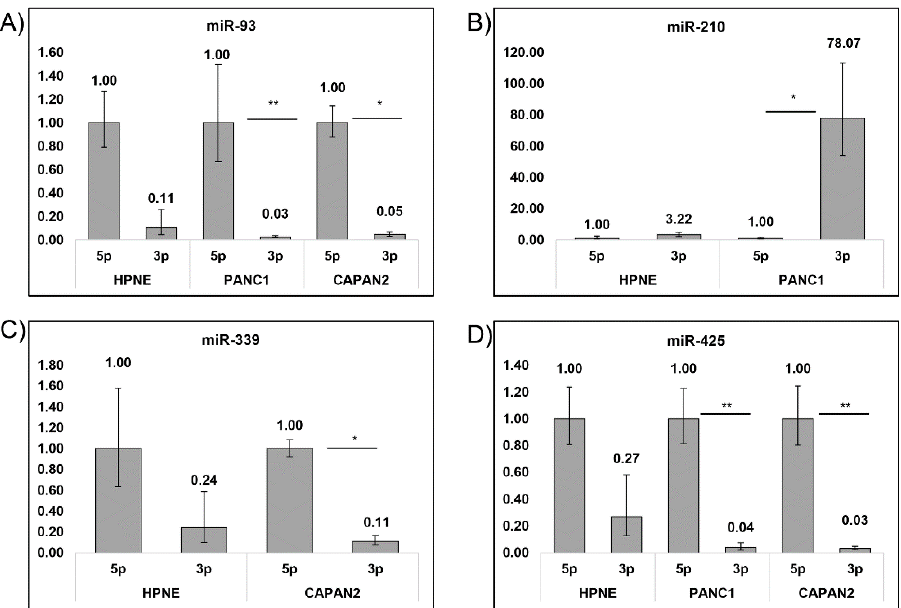
Figure 4. Preference for 5p and 3p arm across PDAC cell lines and HPNE control. Each cell line was examined for a preference in 5p or 3p arm of the mature miRNA Expression levels were calculated relative to the 5p arm of each miR and displayed as fold change values. ( A ) miR-93-5p was preferred in PANC1 and CAPAN2, while ( B ) miR-210-3p was preferred in PANC1. ( C ) miR-339-5p was preferred in CAPAN2 and ( D ) miR-425-5p were preferred in both PANC1 and CAPAN2. Significant ( p ≤ 0.05, *) and very significant ( p ≤ 0.01, **) are also noted and were determined using the student’s t -test.